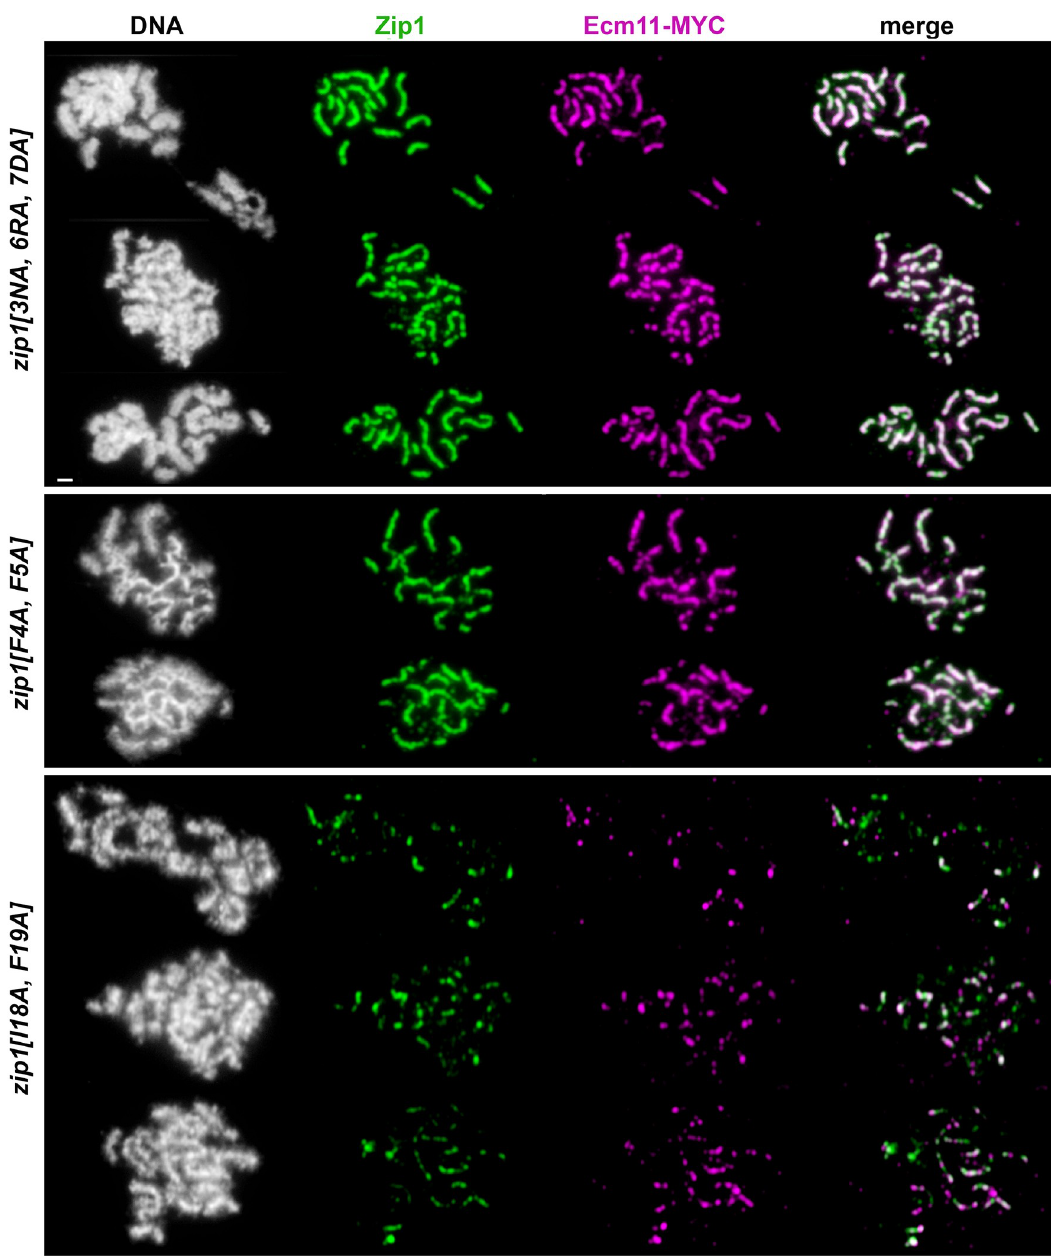
Fig 9. zip1[N3A , R6A , D7A] and zip1[F4A , F5A] and zip1[I18A , F19A] mutants resemble corresponding small deletion alleles with respect to synapsis. Panels show representative surface-spread mid-meiotic prophase nuclei from zip1[N3A , R6A , D7A] (K969; top panel including 3 rows), zip1[F4A , F5A] (AM4067; middle panel including two rows) and zip1[I18A , F19A] (K985; bottom panel including three rows) mutants, with genotypes indicated at left. All strains carry an ndt80 null allele, which allows meiotic cultures to accumulate at mid-late prophase stages when full-length SCs are normally present. Mid-meiotic prophase chromosomes are stained with DAPI to label DNA (white), anti-Zip1 (green), and anti-MYC to label the epitope-tagged Ecm11 expressed in these strains (magenta). The merge between Zip1 and Ecm11-MYC channels is shown in the final column. in meiotic crossovers, and crossovers in this mutant are not further reduced by removal of MSH4 , indicating that zip1[F4A , F5A] meiotic cells lack MutS γ -mediated crossovers (S2 Table). Crossovers did further diminish from their intermediate level when MSH4 was removed from zip1[I18A , F19A] mutants (S2 Table).